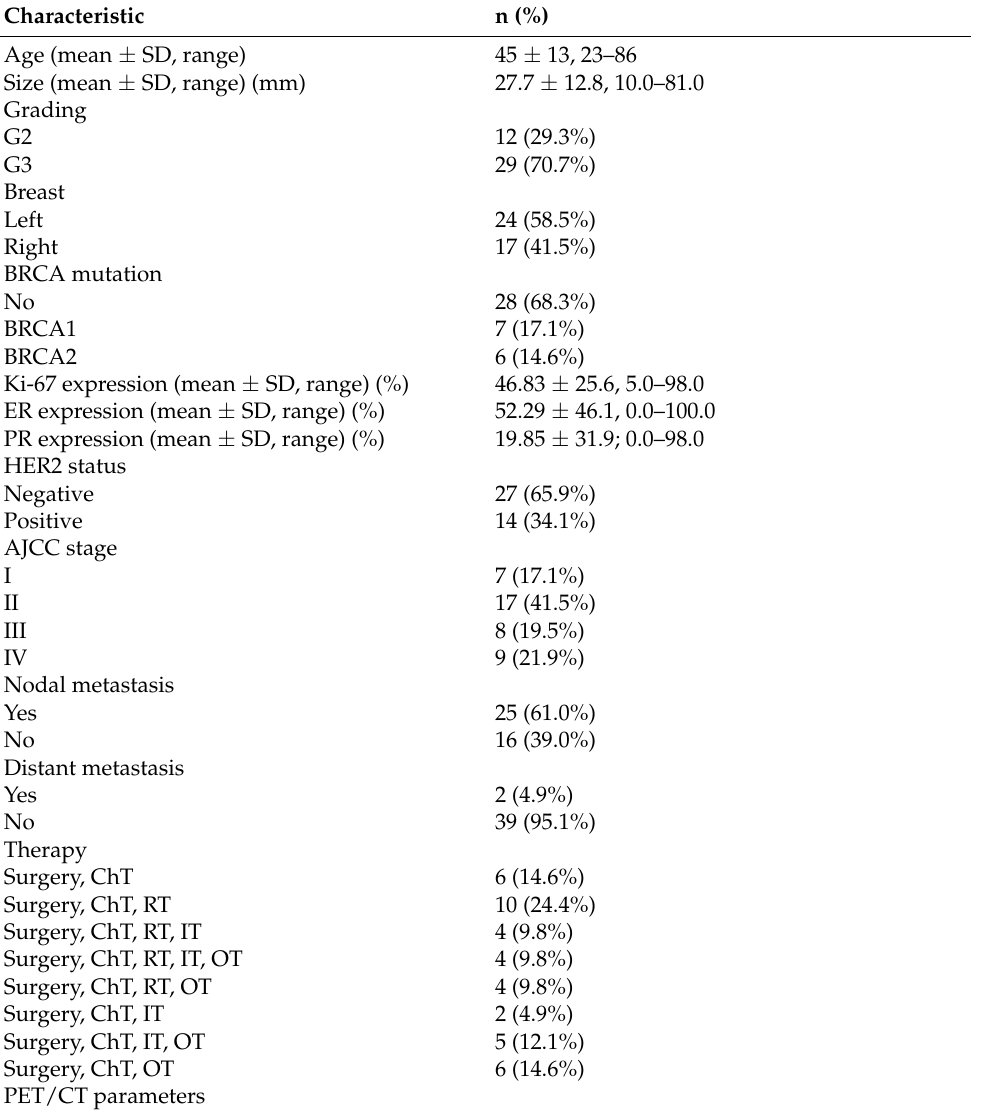
Table 1. Characteristics of the 46 patients included in the